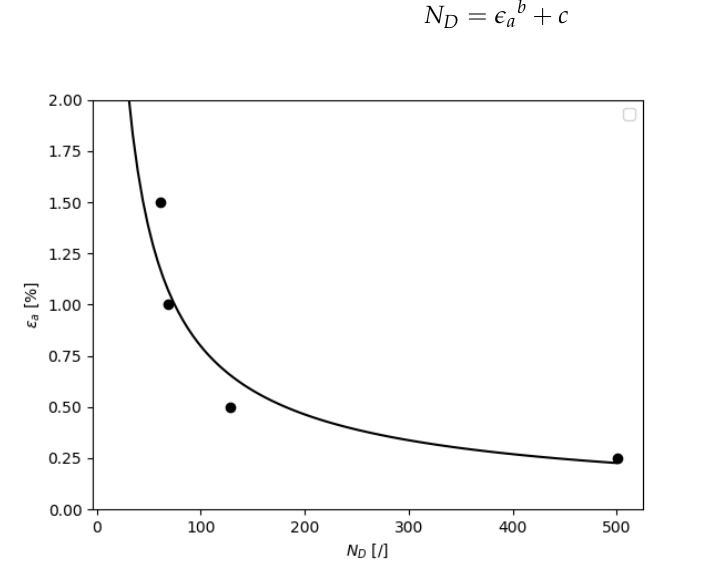
Figure 8. Fitted (cid:101) a - N D (strain-life) exponential damage